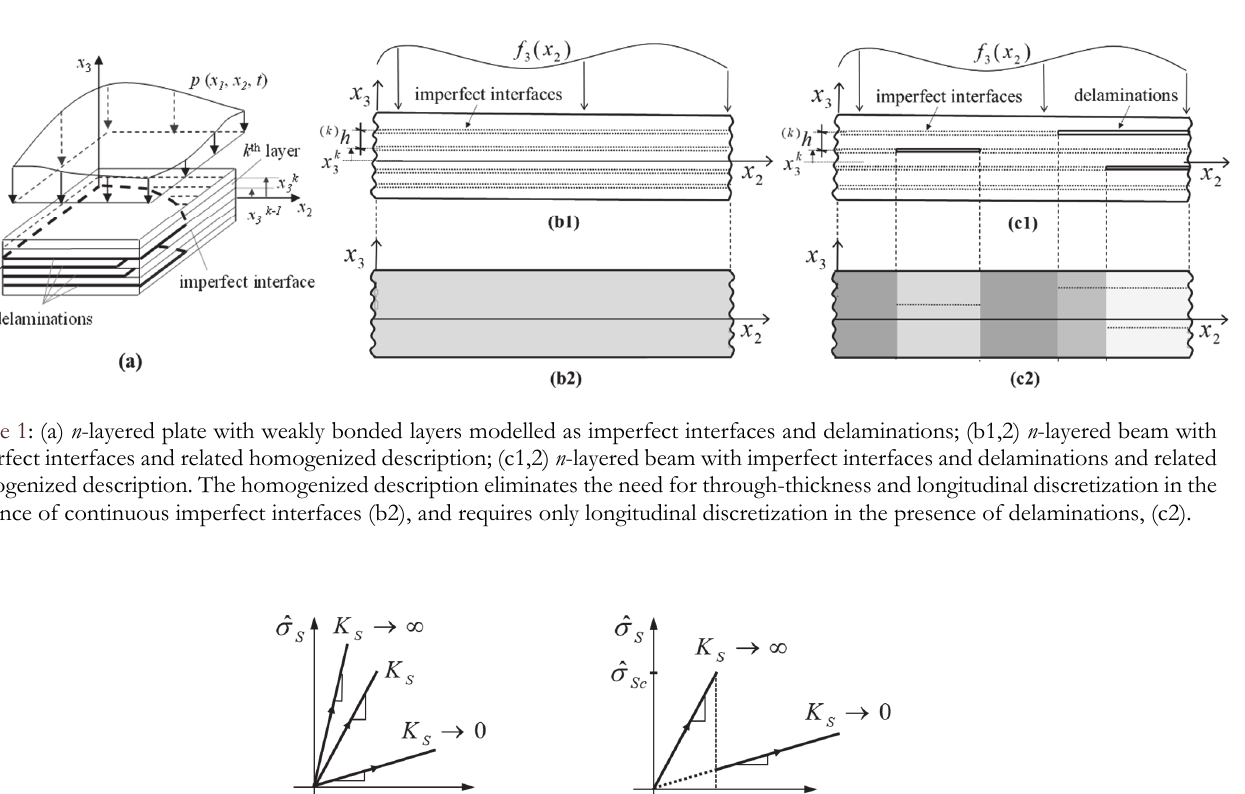
ˆ ˆ v v  . , and 2 2 c